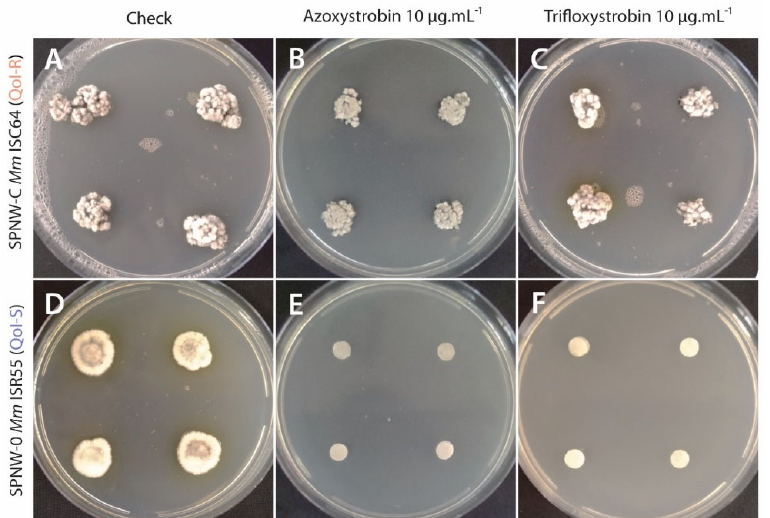
Figure 3. Two isolates of Mycosphaerella musicola with contrasting sensitivity to QoI fungicides a . a Colonies grown on potato dextrose agar medium without fungicide ( A , D ) or amended with azoxystrobin ( B , E ) or trifloxystrobin ( C , F ) at a discriminatory dose of 10 μ g ꞏ mL − 1 ; SPNW ‐ C Mm isolate ISC64 is resistant to QoI (QoI ‐ R) while SPNW ‐ O Mm isolate ISR55 is sensitive to QoI (QoI ‐ S). The sensitivity assays also revealed cross ‐ resistance to both QoIs fungicides tri ‐ floxystrobin and azoxystrobin as all strains showed resistance to both compounds (Table 2). The frequency distribution of resistant and sensitive isolates to QoI fungicides indi ‐ cated no resistant individuals in the population Mm SPNW ‐ O (organic field) (37 strains tested, whereas 7% (two out of 25) were detected in the Mn population MGN ‐ C (con ‐